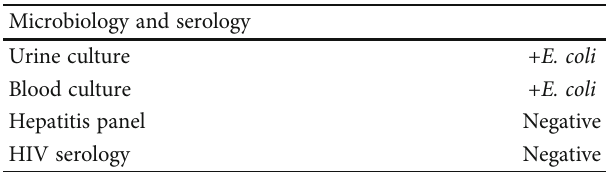
Table 2: Urinalysis upon initial presentation to outside facility on April 19, 2021.